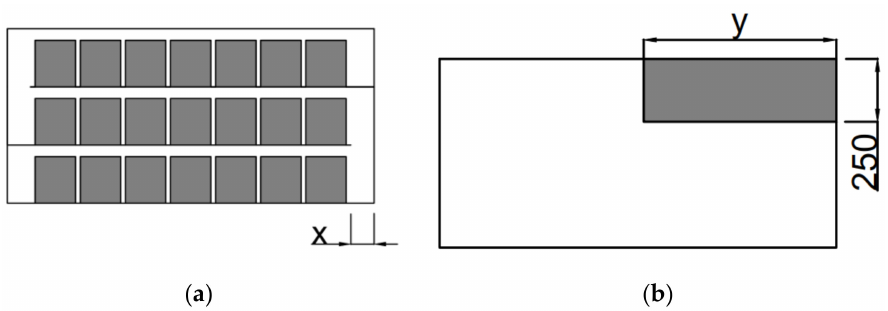
Figure 12. ( a ) Schematic diagram of the width of partition gap; and ( b ) schematic diagram of air outlet